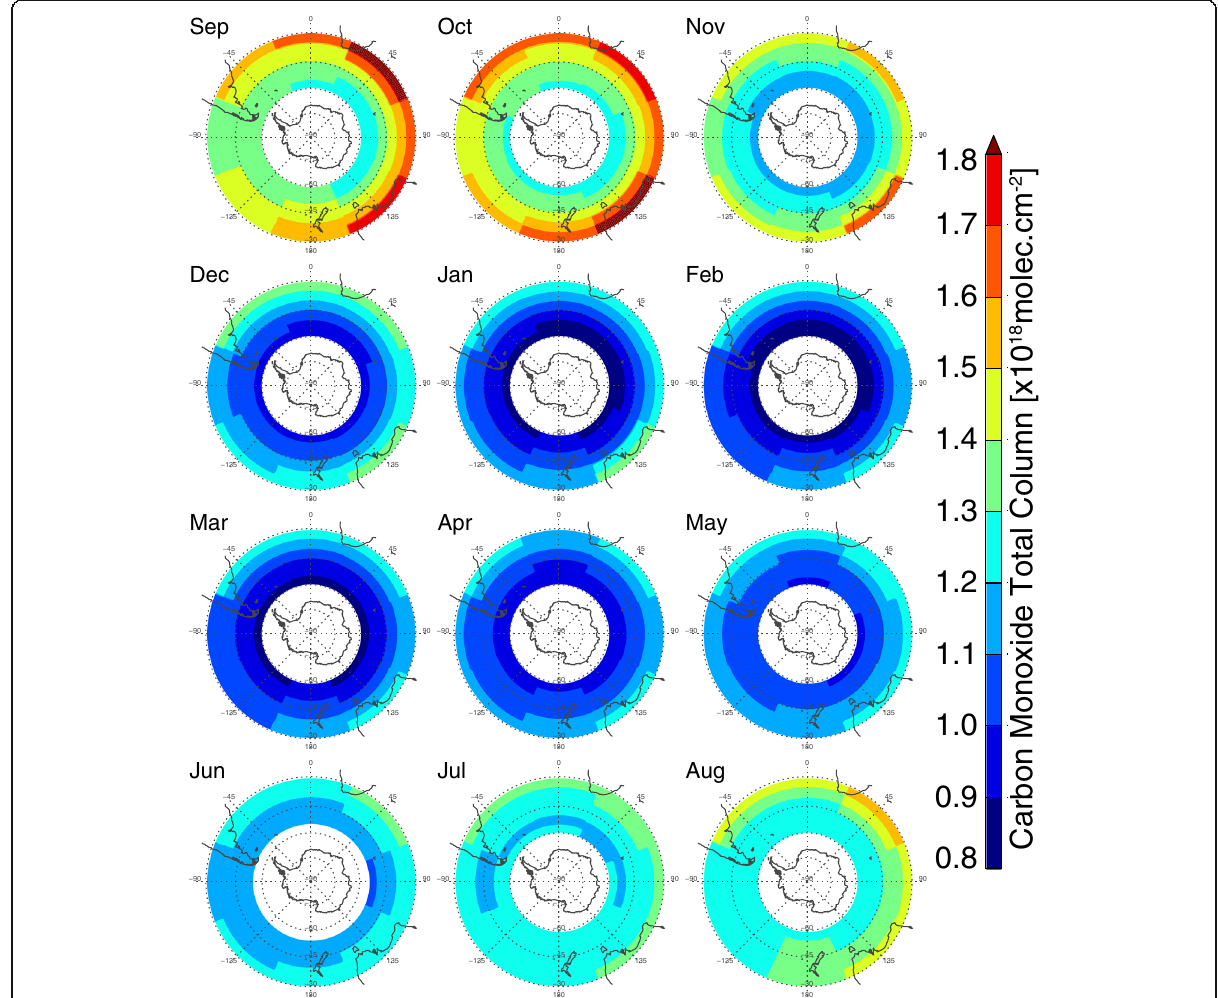
Fig. 2 Climatological monthly mean distribution of the MOPITT carbon monoxide (CO) total column (×10 18 molecule cm − 2 ) at 30 – 60° S. The color in each pixel reveals the median CO value for all available measurements from 2005 to al. 2012). Since CO is mostly emitted from continental sources, CO levels over the Antarctic gradually decrease with increasing distance from the source regions. How- ever, some high CO concentrations can be found over the ocean; we attribute these instances to the transport of CO from emission sources. Nitrogen dioxide NO is a trace gas usually emitted from anthropogenic 2 sources such as vehicles and power plants (Beirle et al.